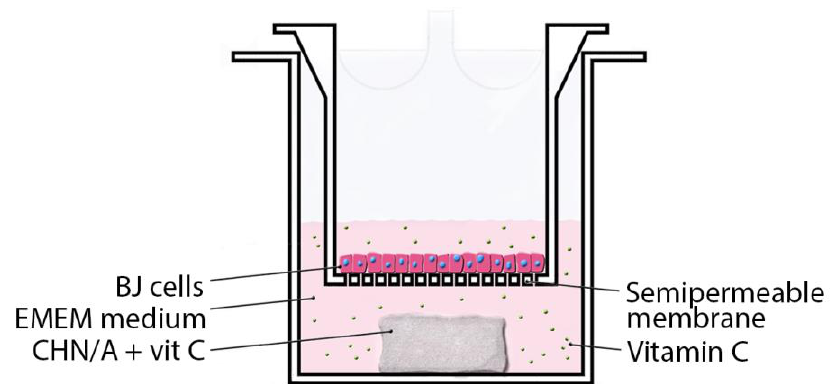
Figure 1. Schematic representation of the process of BJ culturing on the hanging cell culture inserts, providing two-compartment environment during cell culture tests.